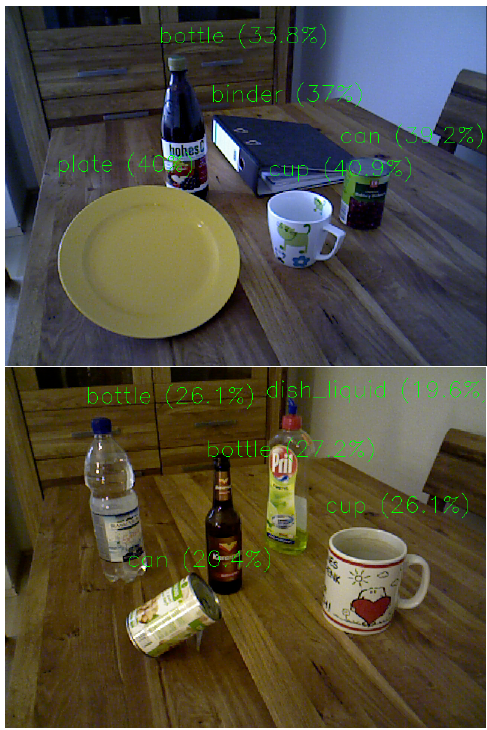
Figure 7. Exemplary result for object